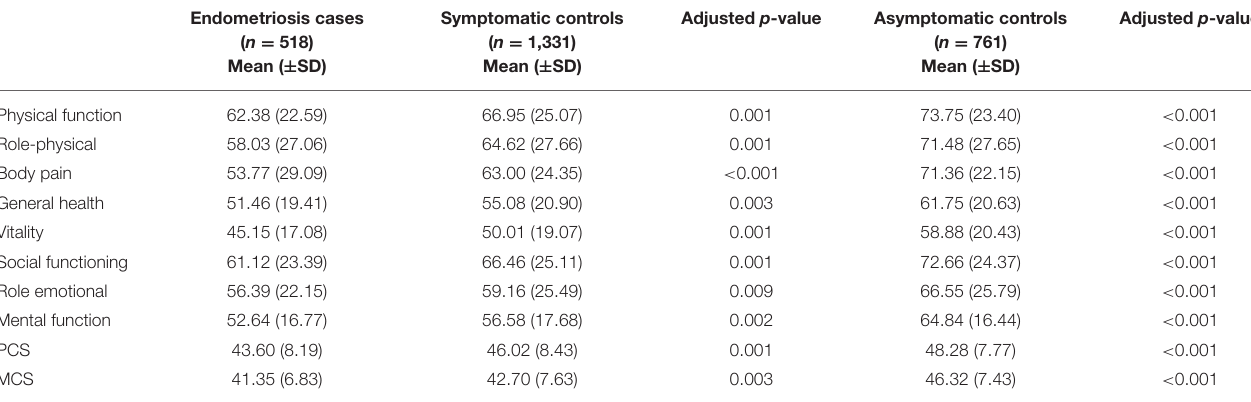
TABLE 2 | Association of endometriosis and HRQoL in comparison to symptomatic controls and asymptomatic controls, measured using the SF36v2 dimensions and composite scores. Endometriosis cases ( n =